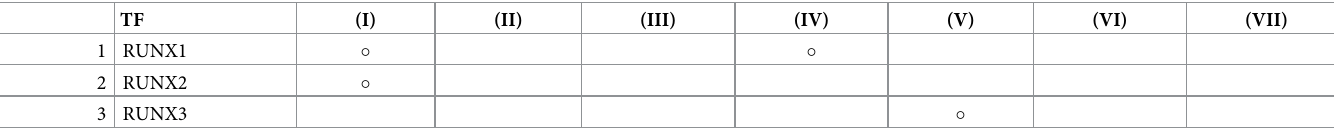
Table 4. Identification of RUNX transcription factor (TF) family members within seven TF-related categories in Enrichr. Roman numerals correspond to the first col- umn in Table 3.